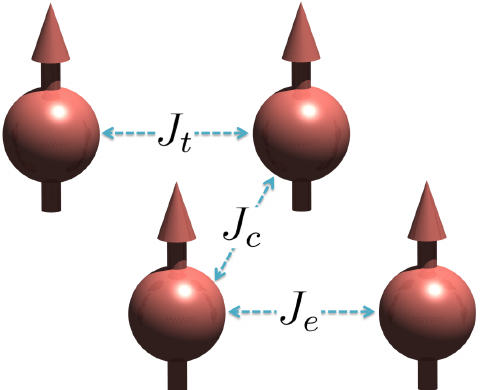
Figure 3. Schematic diagram showing that the Fe wires have the ferromagnetic ground state and the magnetic interactions within the Fe wires: J t , J c , and J e . Table 1. Exchange constants for the freestanding Fe chain, freestanding Fe wires, and the embedded Fe wires. The definition of the constants in the Heisenberg model incorporates the magnetic spin moments. All values are given in